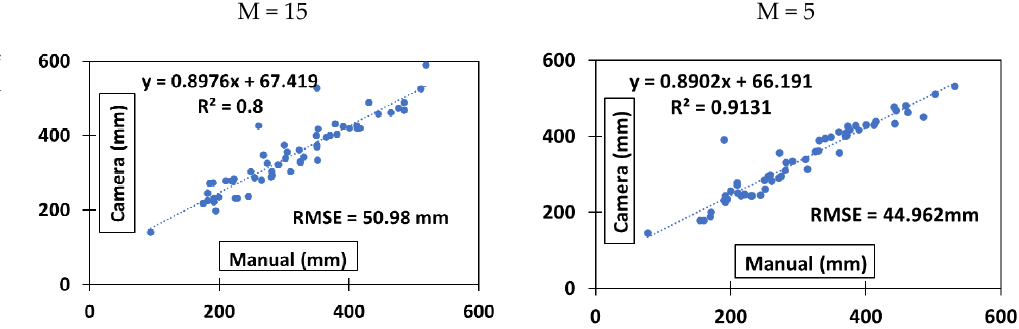
Figure 13. Segmentation results and masking of the images.